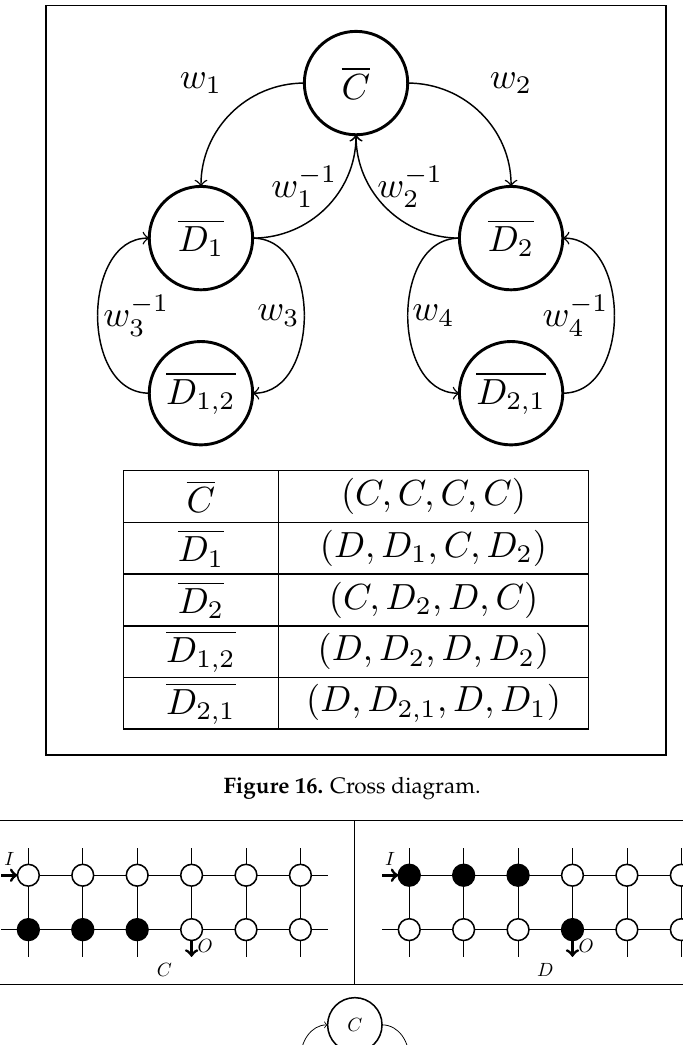
Figure 17. Cross